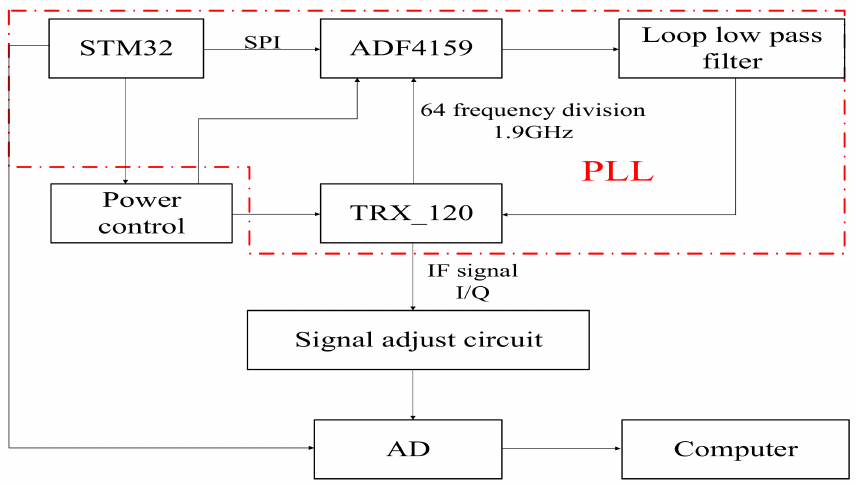
Figure 1. Hardware structure of vital signs monitoring